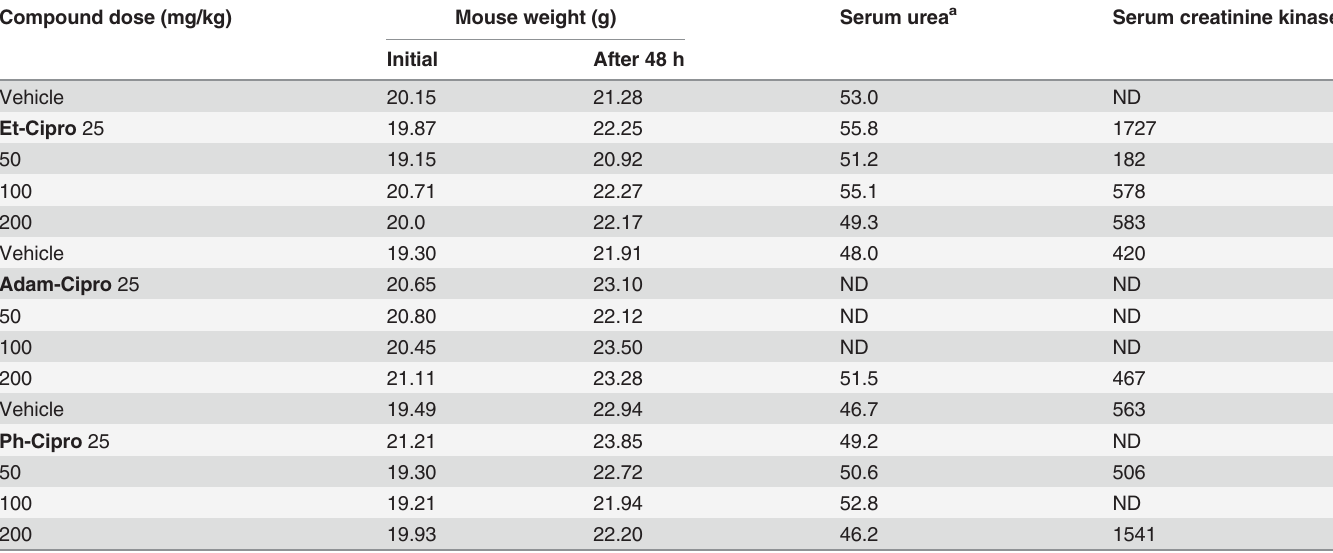
Table 1. Toxicity of ciprofloxacin derivatives in